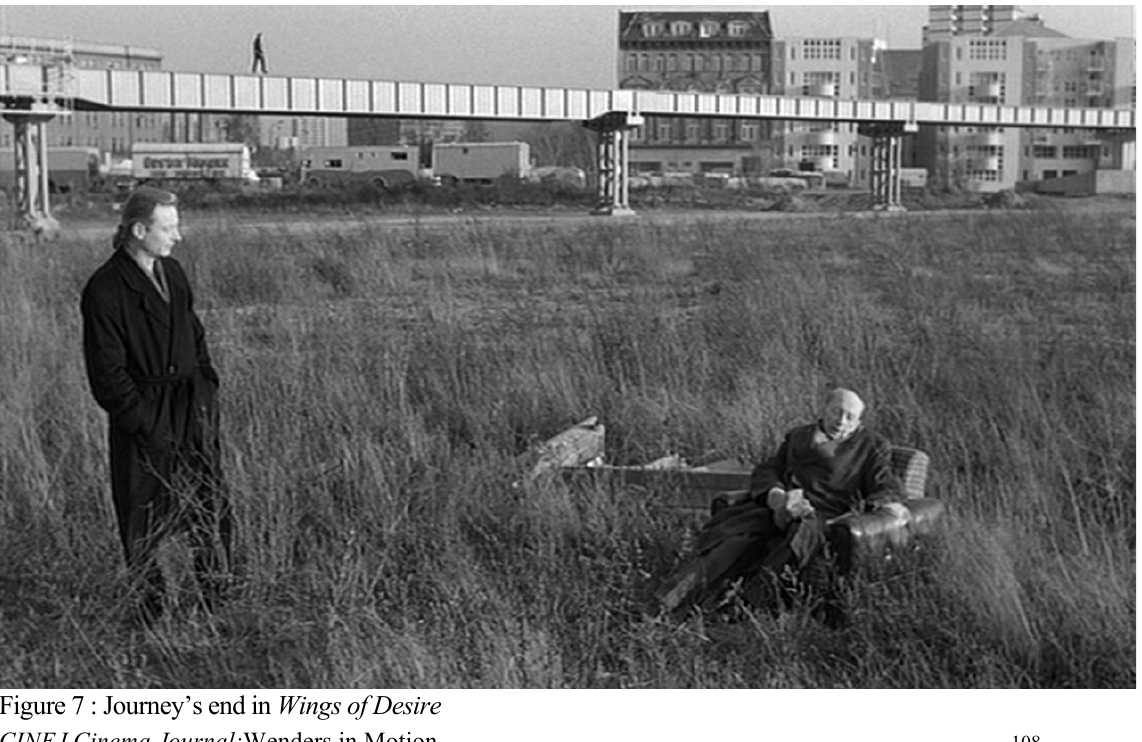
Figure 7 : Journey’s end in Wings of